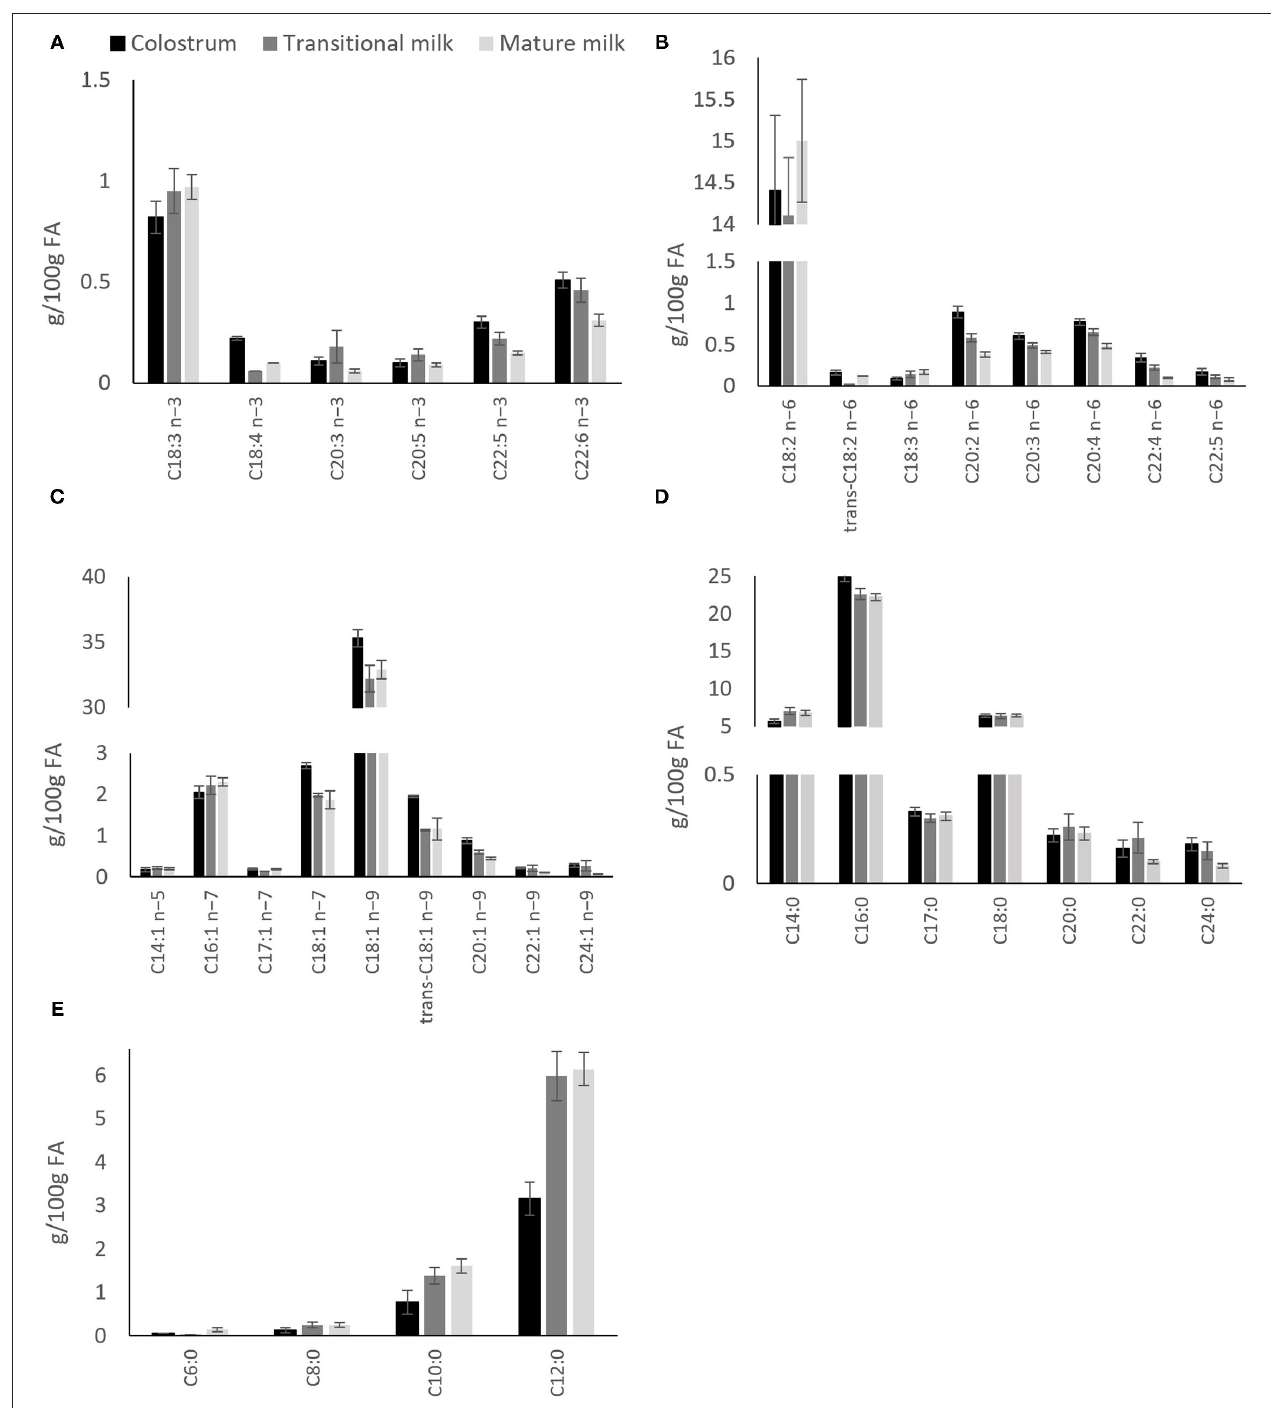
FIGURE 3 | Distribution of individual fatty acids in colostrum, transitional milk and mature milk after pooled data analysis of worldwide milk samples reported by Floris et al. (28). (A) n-3 polyunsaturated fatty acids; (B) n-6 polyunsaturated fatty acids; (C) Monounsaturated fatty acids; (D) Saturated fatty acids and; (E) Medium chain (C6-C12) saturated fatty